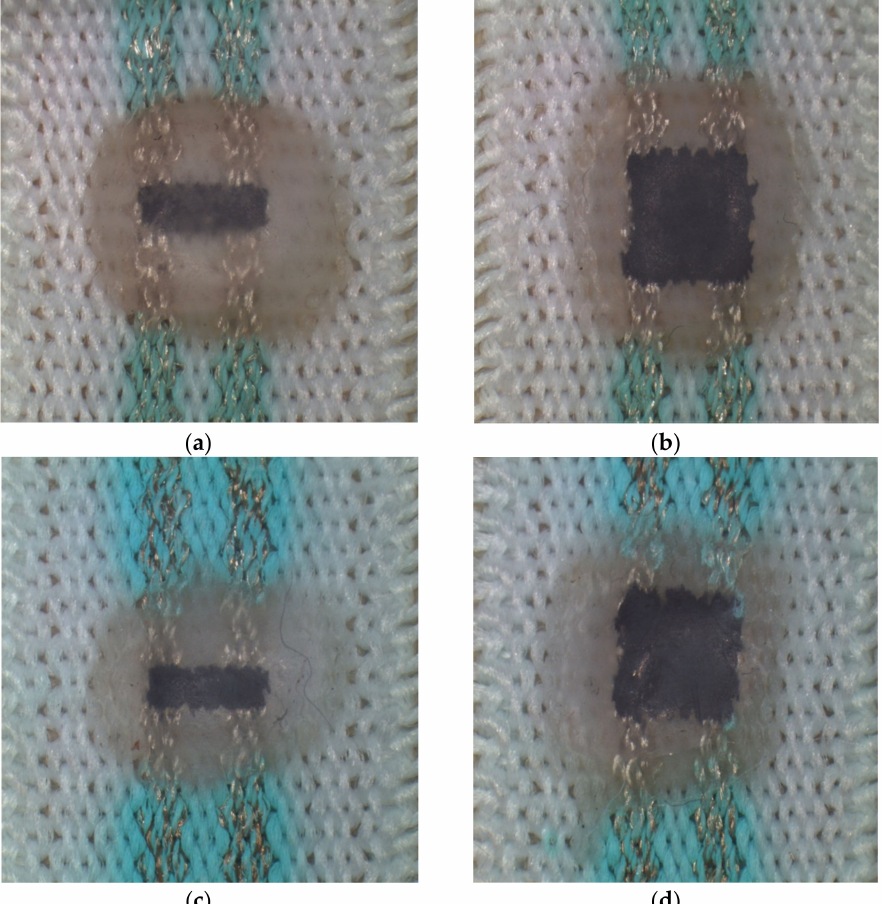
Figure 17. Example of graphene sensor samples after aging by artificial sweat (alkaline—( a , b ); acidic—( c , d